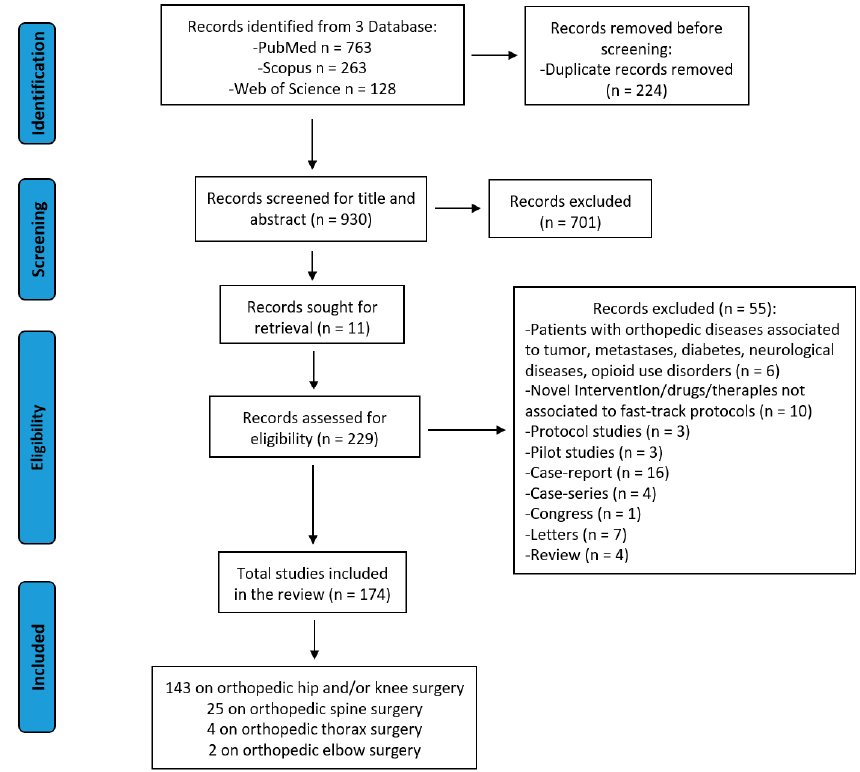
Figure 1. PRISMA 2020 flow diagram for the selection of studies.